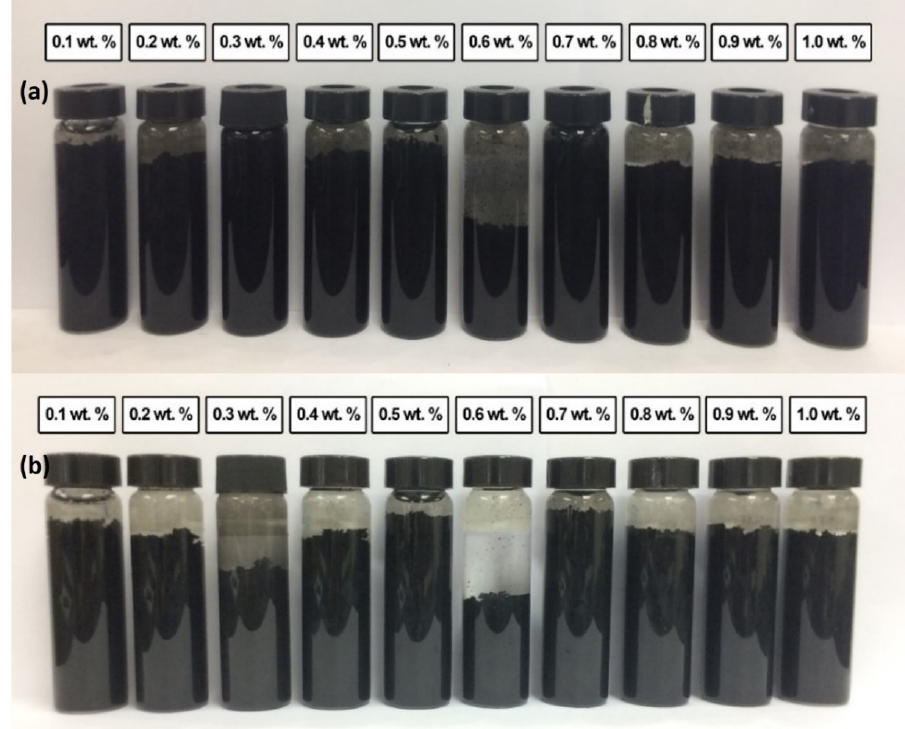
Figure 5. Stability and dispersion condition of various weight percentages of the commercial NTs based nanofluid without surfactant for ( a ) 0.5 h; ( b ) 100 h after homogenization and sonica- tion